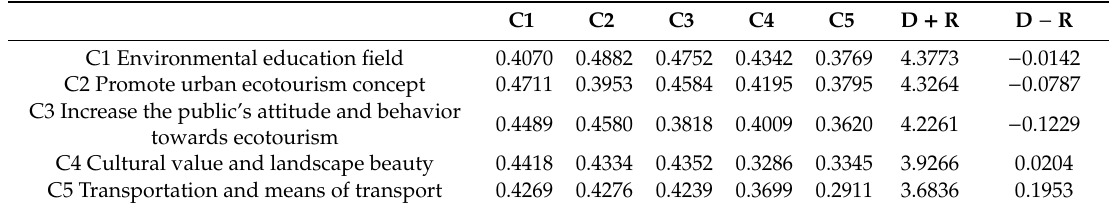
Table 5. DEMATEL results for the social aspect.